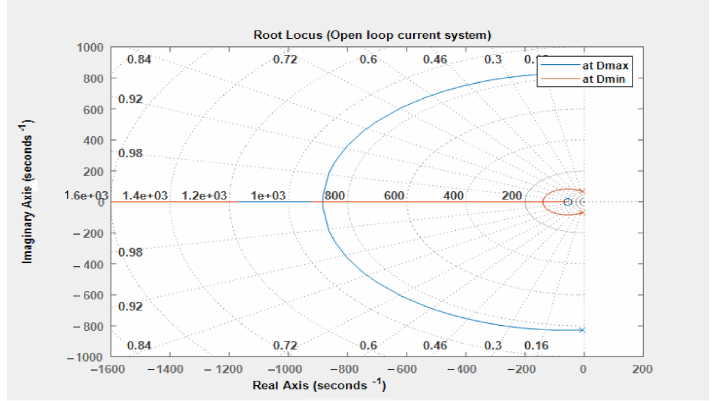
Figure 10. Root locus plot of the open loop current system with different duty cycle. Figure 11 shows the bode plot of the open loop of the inductor current system. The peak resonance frequency is proportional to the duty cycle value, and the converter high bandwidth available is proportional to the high duty cycle of the converter.